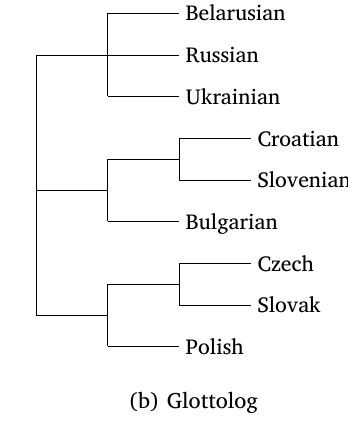
Figure 4: Phylogenetic trees for the Slavic language family, using structured perceptron prediction, and the Glottolog reference tree. Quartet distance between trees: